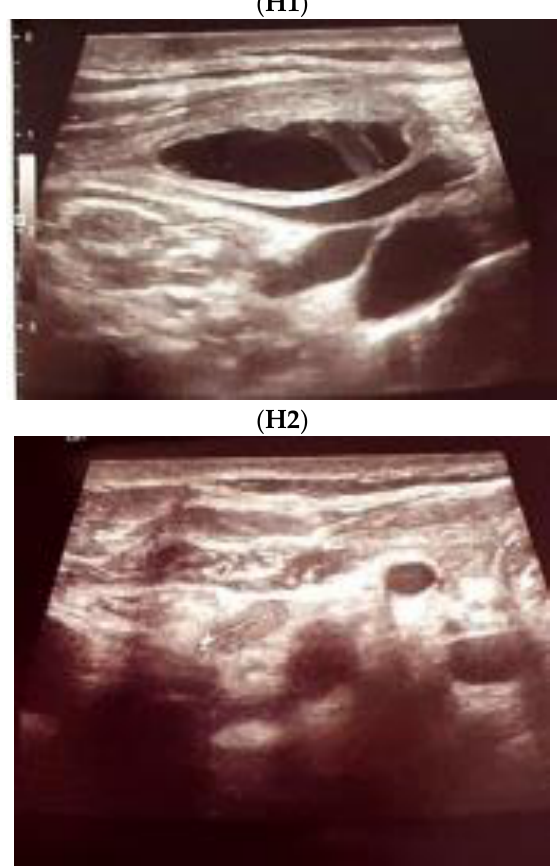
Figure 4. The evolution of within following weeks after thyroid surgery ultrasound features. ( A ). Right neck ultrasound aspect at the moment of fine needle aspiration (5 weeks since surgery) — on the right and 6 days after fine needle aspiration procedure (after cvasi-complete evacuation, the cystic mass relapsed within 48 h) — on the left. ( B ). Right neck ultrasound within the first day of tube drainage (6 weeks since initial surgery) showing a massive reduction of the cystic mass. ( C ). Drain- age tube was removed after 4 days. Post-thyroidectomy scar and post-tube removal aspect. ( D ). Right neck ultrasound after 2 weeks from removing the drainage — persistent cystic mass, but with progressive improvement of HS (approximately 9 weeks since initial surgery). ( E ). Right neck